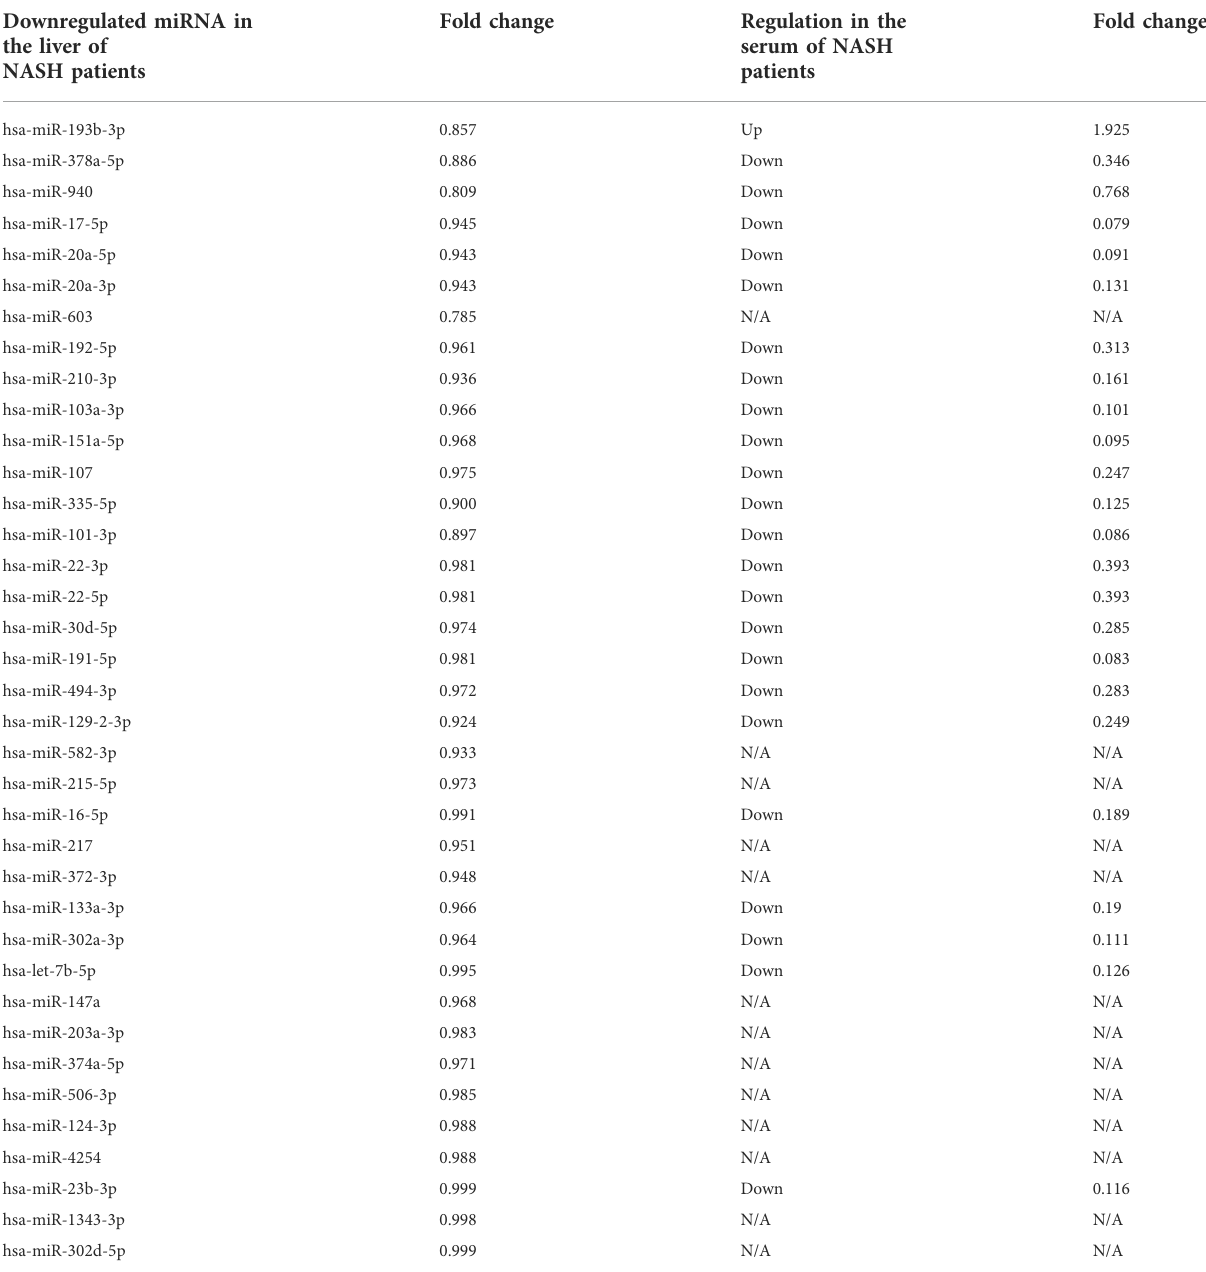
TABLE 4 Veri fi cation of miRNA in the liver and serum of NASH patients. Downregulated miRNA in the liver of NASH